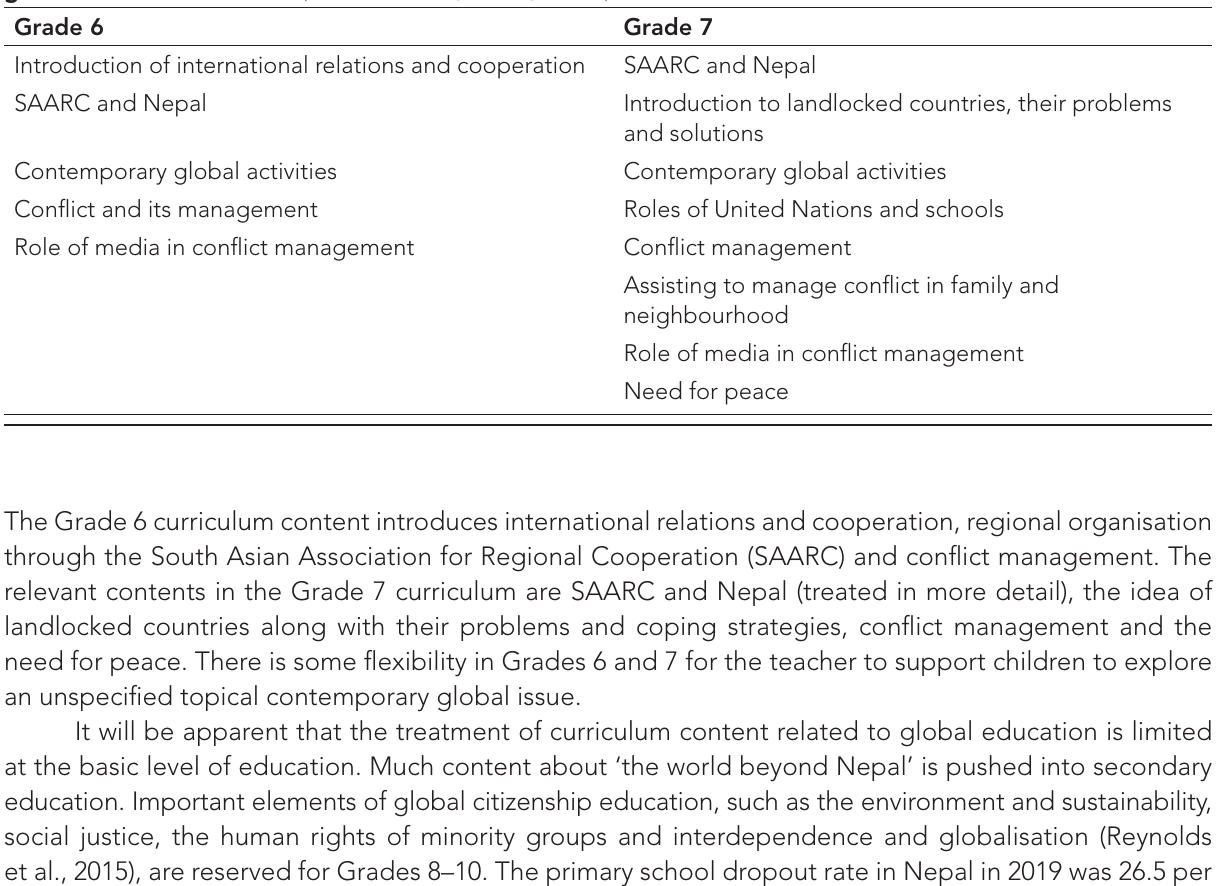
Table 1. Social studies curriculum in Grades 6 and 7: Scope and sequence of the contents in relation to global education themes (Source: CDC, 2009,